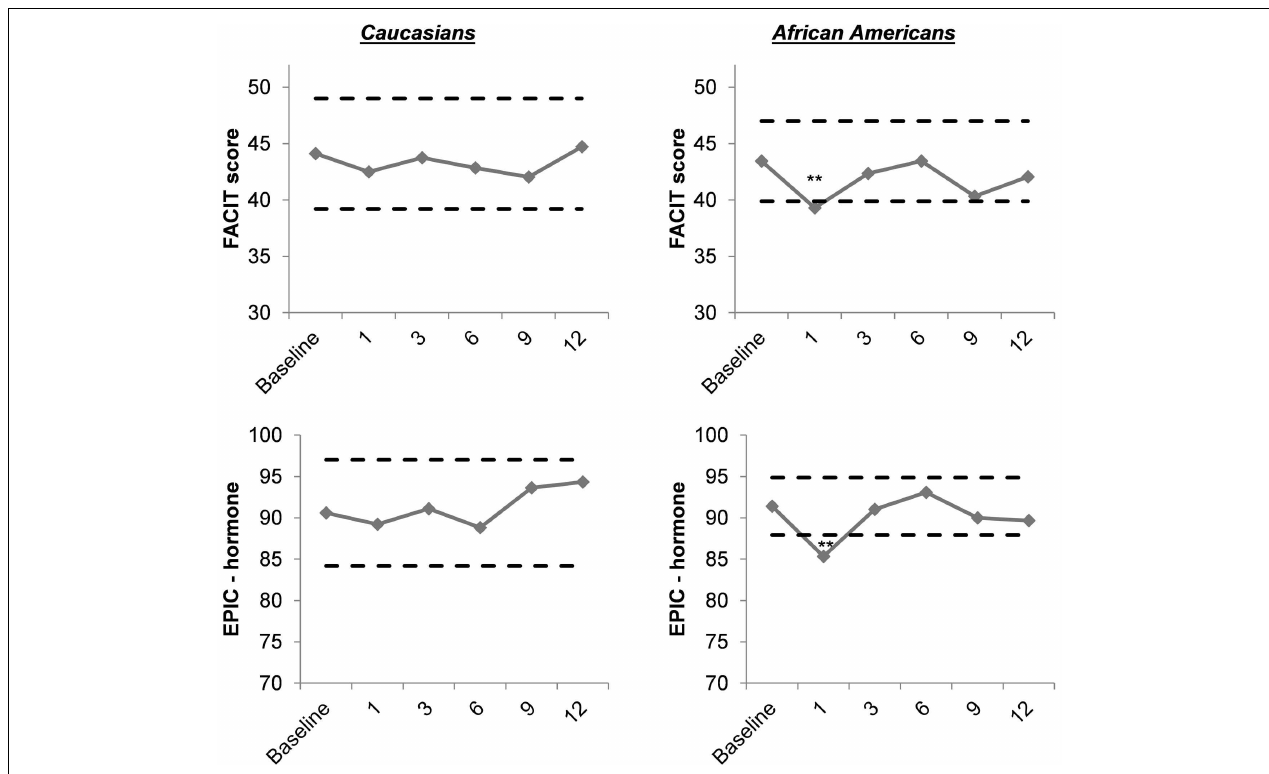
standard deviation suggests clinical significance. **Change from baseline statistically significant at <0.01 level. *Change from baseline statistically significant at <0.05